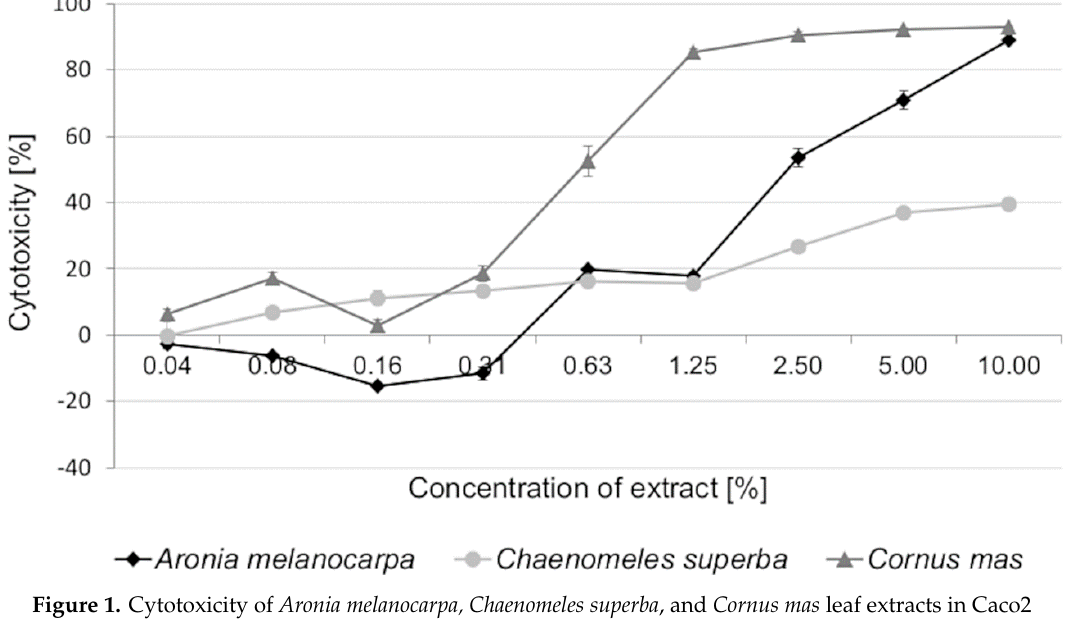
Figure 1. Cytotoxicity of Aronia melanocarpa, Chaenomeles superba, and Cornus mas leaf extracts in Caco2 cells estimated using the MTT assay after 72 h of exposure. Each data point represents the mean of the absorbance values for cells from four individual wells (±SD).